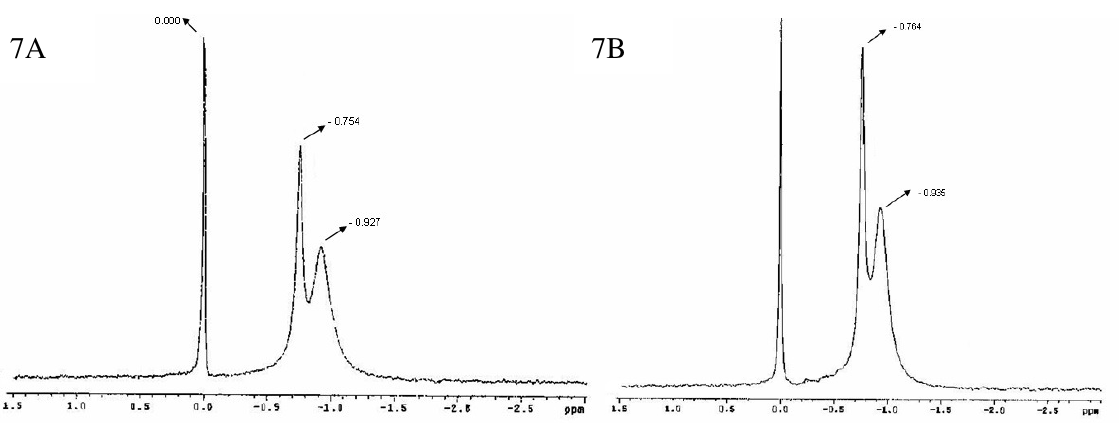
Figure 7. P NMR spectra spectra at 20 °C for DMP/DHPC bicelles ( q = 2 and 80% water content) 24 h ( A ) and 14 days ( B ) after preparation.